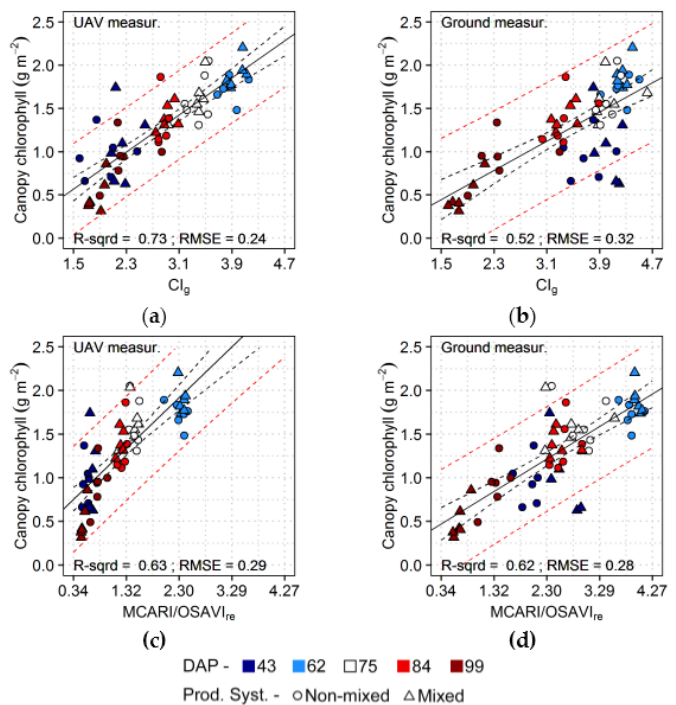
Figure 8. Best vegetation indices for prediction of canopy chlorophyll content from UAV and ground-based data ( a , d , respectively) and corresponding results for ground-based and UAV measurements ( b , c , respectively). Red and black dashed lines indicate prediction and confidence intervals with 95% confidence level, respectively.